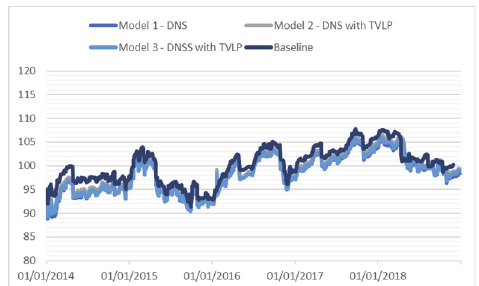
Fig. 8 . Fair price result comparison for FR0061 Fig. 9 . Fair price result comparison for